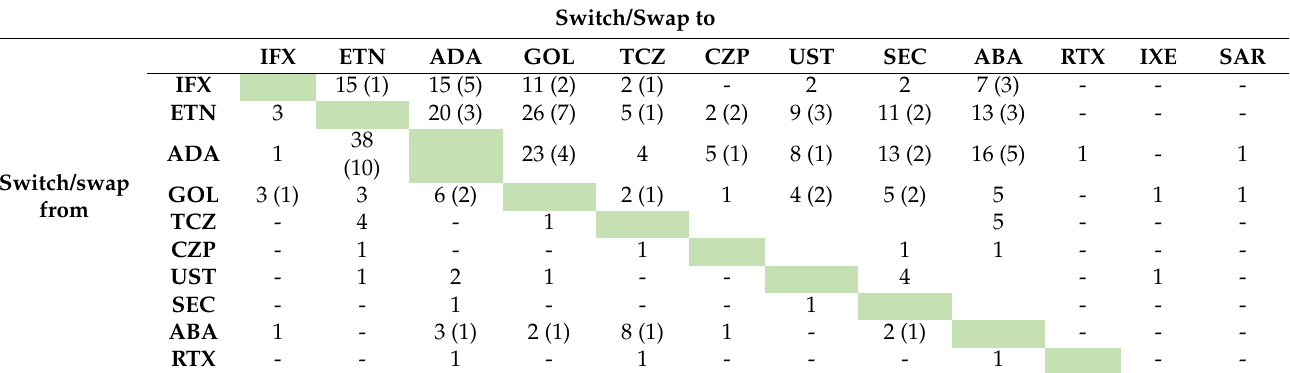
Table 3. Summary of biologic drugs switch/swap.